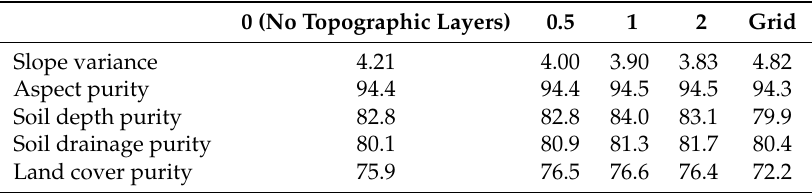
Table 1. Homogeneity of the image-segment as a function of the segmentation weights. The grid is composed of squares with the same area as the average of image-segments. Large purity values and low average variance of the slope indicate a good